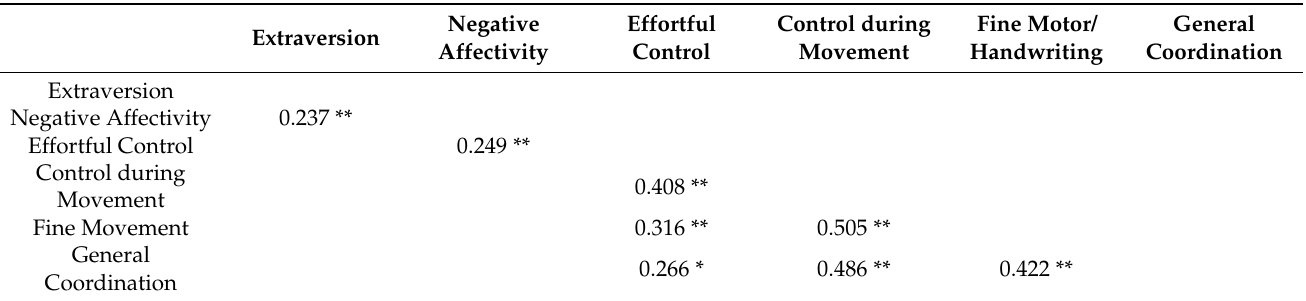
Table 3. Correlations between temperament components and indicators of Developmental Coordination